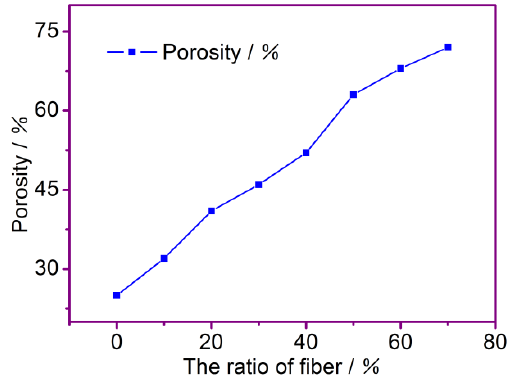
Figure 3. The effect of ratio of fibers on porosity.